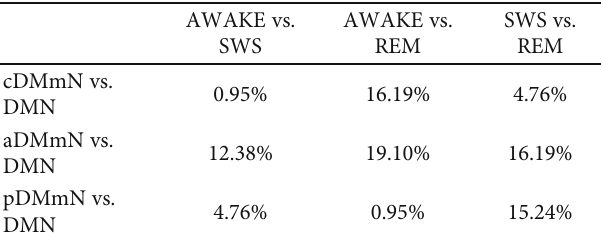
Table 2: Altered rates between the DMN-wide FC alterations in the CAMP networks of three states of consciousness and those in the original